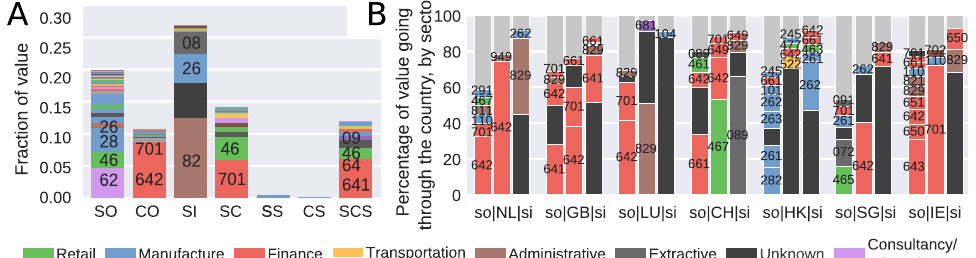
Figure 5. Sectoral specialization. ( A ) Distribution of sectors (NACE Rev. 2) in terms of their dominant position in the chain (Source (SO), Conduit (CO), Sink (SI), Source + Conduit (SC), Source + Sink (SS), Source + Conduit + Sink (SCS)). ( B ) Percentage of revenue going through each country in chains of size three, by sector. The first column visualizes the distribution of sectors in the source country, the second columns visualizes the distribution of sectors in the conduit (horizontal axis), and the third column shows the distribution of sectors in the sink